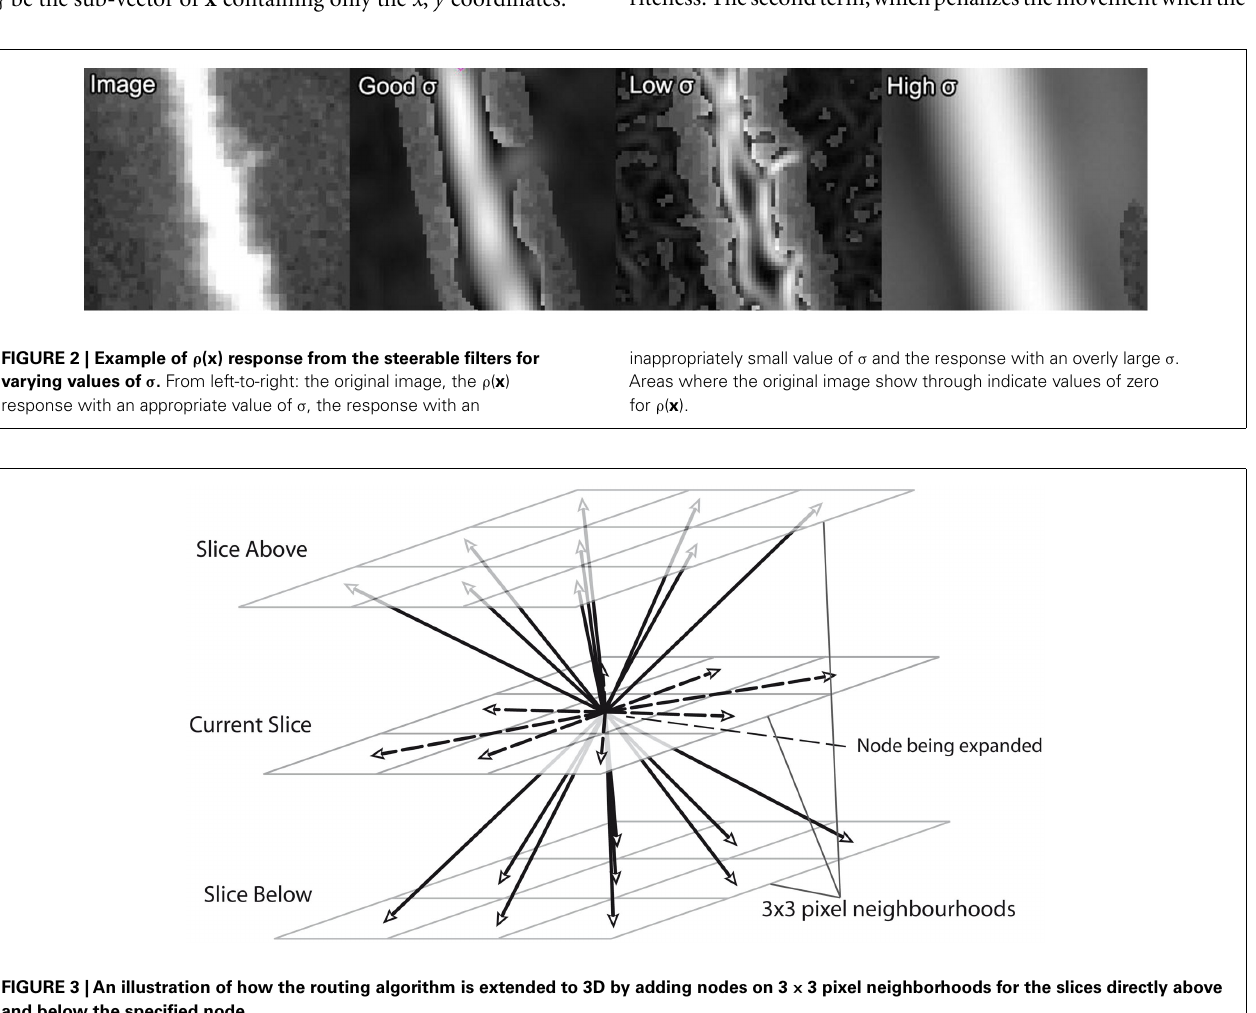
FIGURE 3 |An illustration of how the routing algorithm is extended to 3D by adding nodes on 3 × 3 pixel neighborhoods for the slices directly above and below the specified node.